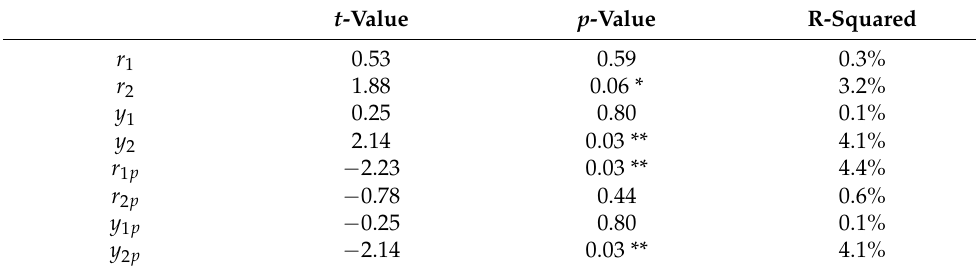
− 0.25 0.1% − 2.14 0.03 ** 4.1% * Significant at 10%. ** Significant at